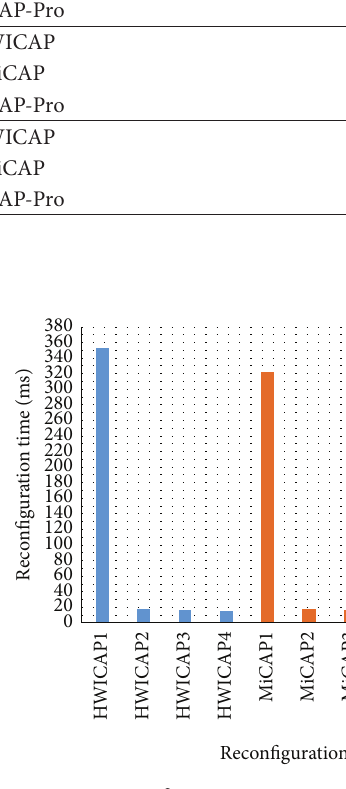
Figure 8: Reconfiguration time comparison between standard reconfiguration driver and custom reconfiguration